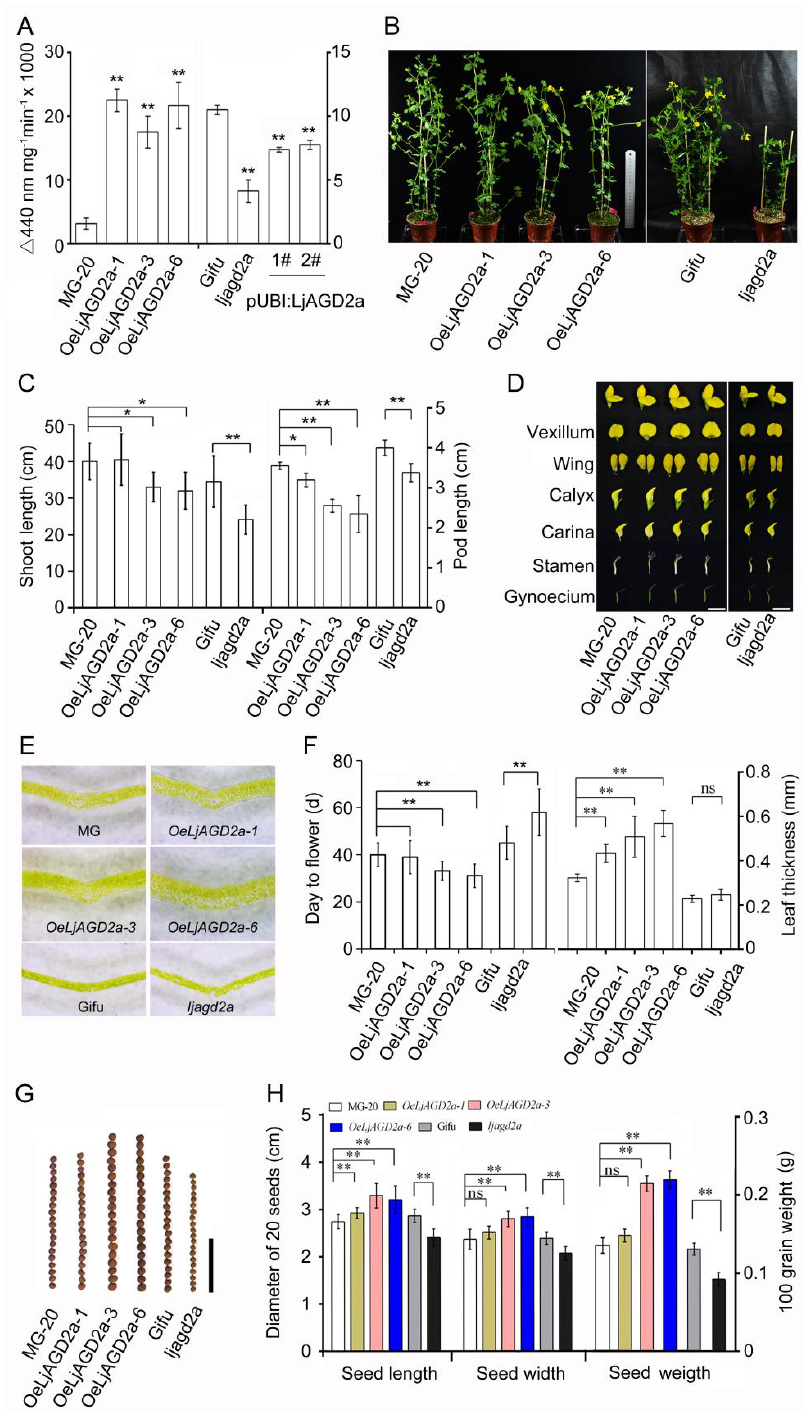
Figure 4. Morphological effects of changing expression of LjAGD2a in L. japonicus . ( A ) LL - diaminopimelate aminotransferase ( LL -DAP-AT) activities, showing a drastic reduction in ljagd2a and a significant increase in OeLjAGD2a lines (means with error bars indicating SD of five